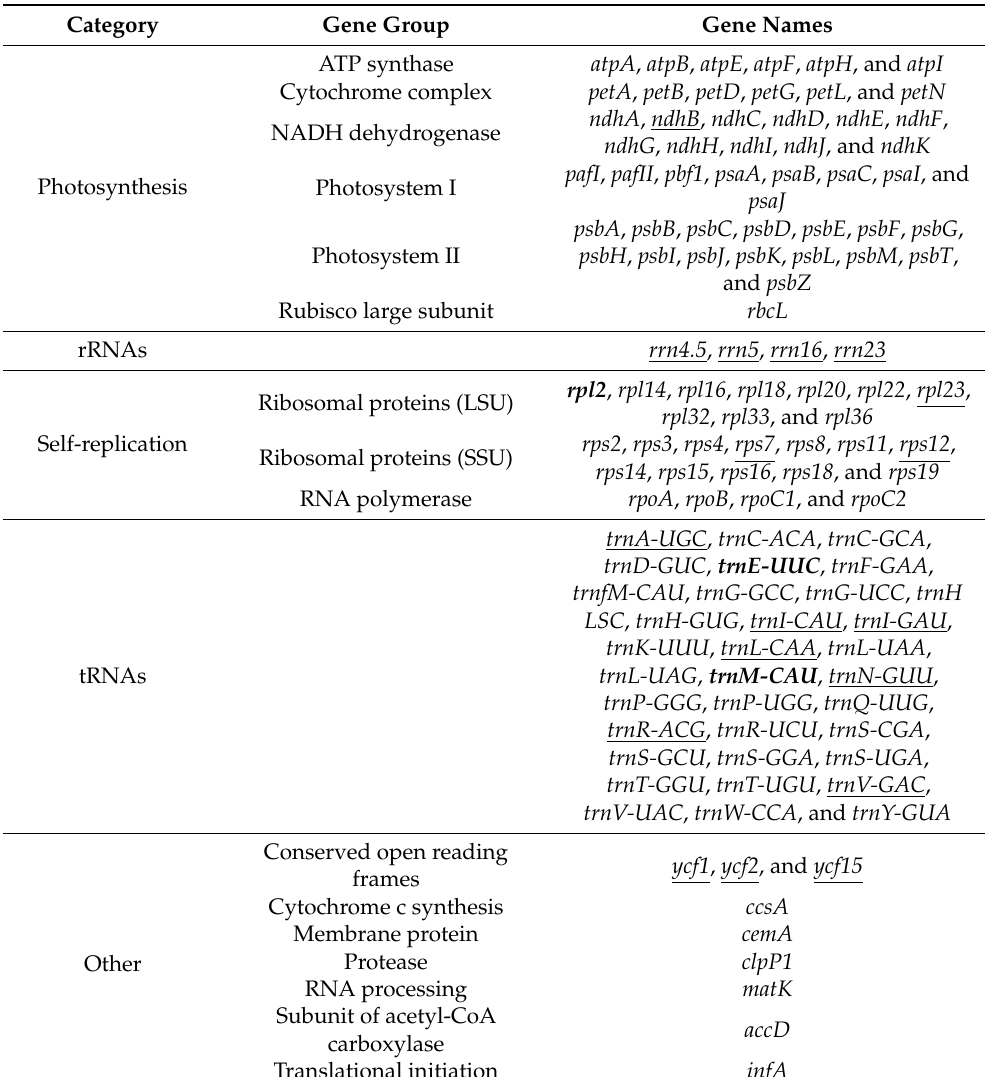
Table 2. Genes found in the 37 Magnoliaceae plastomes. Duplicated genes are underlined. Triplicated genes are in